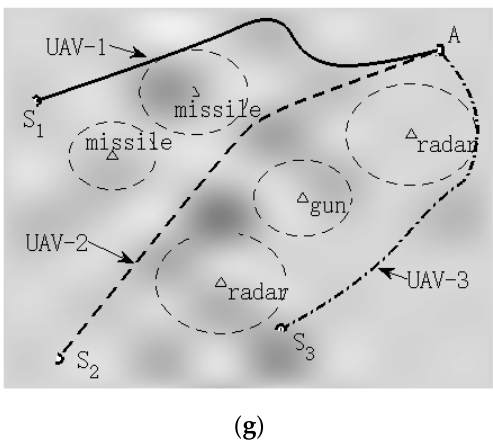
Figure 2. Two-dimensional displays of the best unmanned aerial vehicle (UAV) paths obtained by ( a ) MSFOA, ( b ) FOA, ( c ) PSO, ( d ) DE, ( e ) ABC, ( f ) IFFO, and ( g ) MFOA in the first scenario.